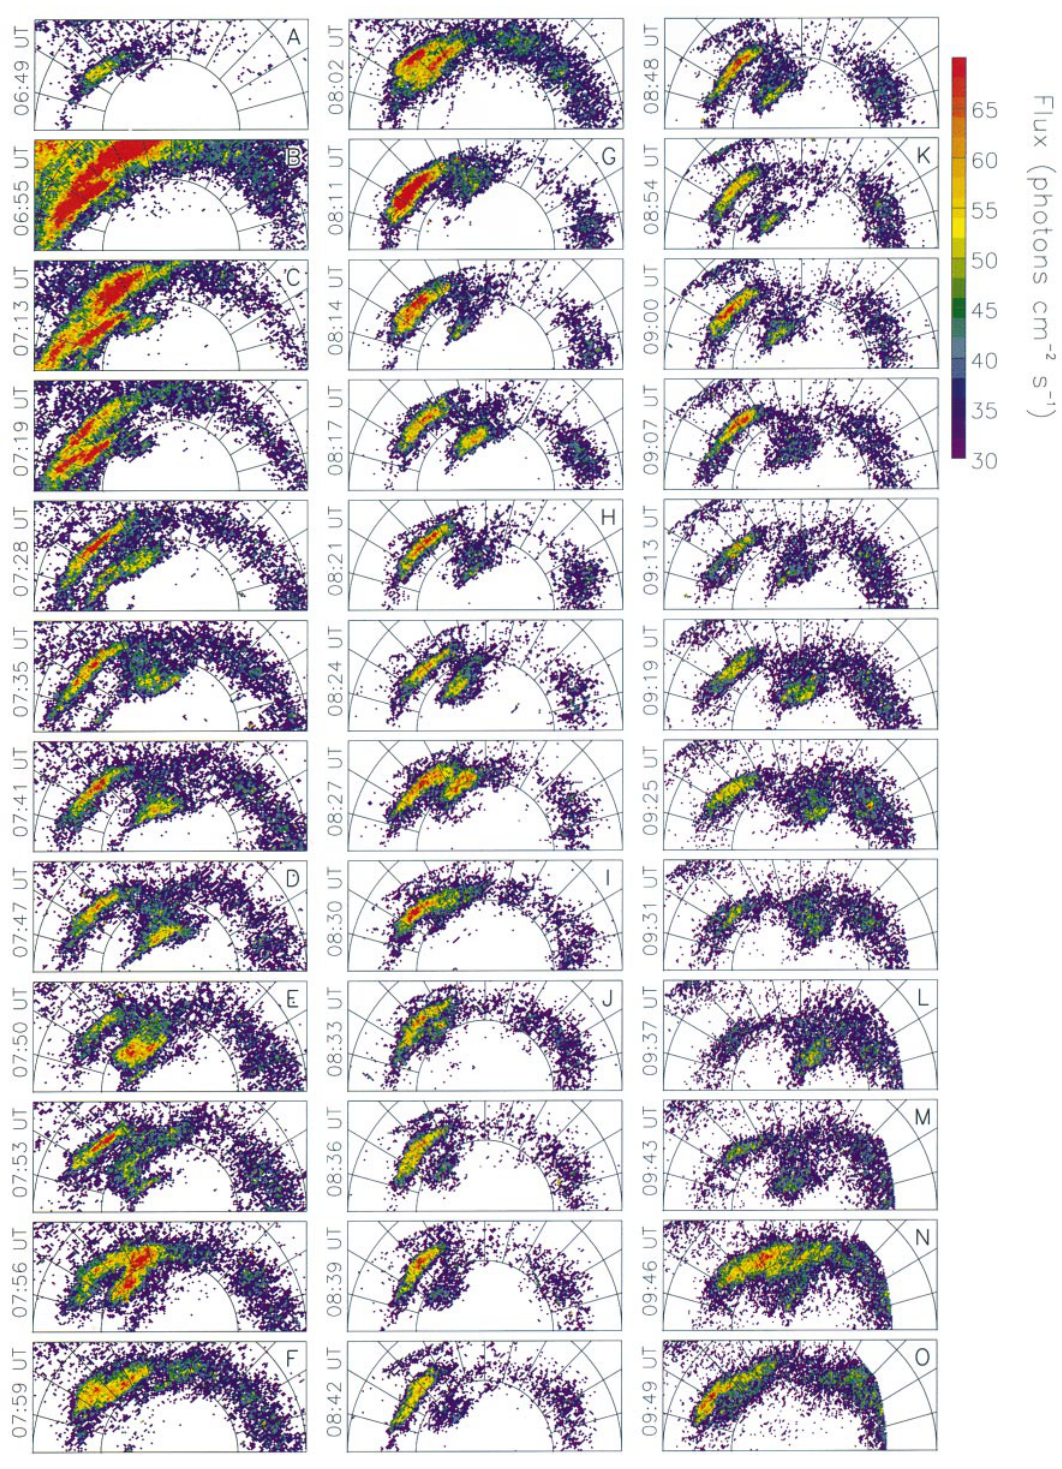
Fig. 2. A sequence of Polar UVI images, taken with the LBHs filter at an integration time of 36 s. The images are displayed in polar magnetic latitude and MLT coordinates, with 12 MLT towards the top of each panel , and 06 and 18 MLT in the bottom right and left